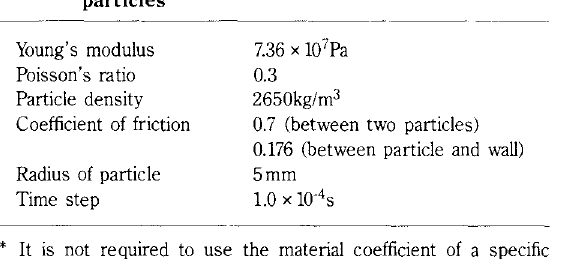
Table 1 Computational condition for simulation of flowing